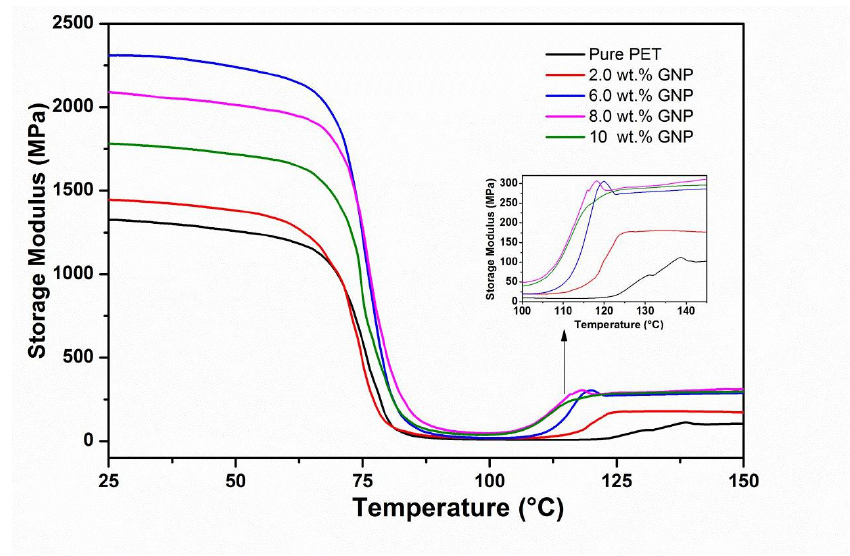
Figure 4. DMTA dynamic storage modulus data of PET-GNP